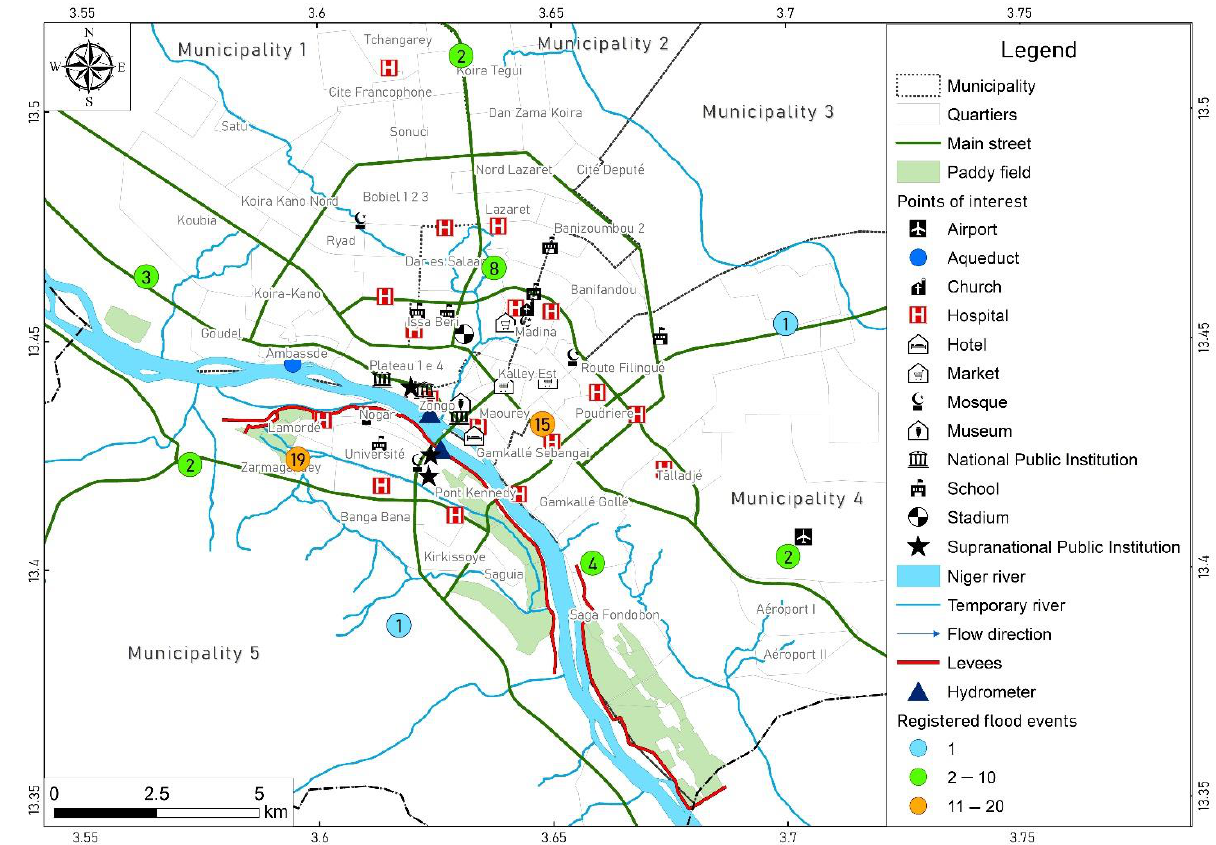
Figure 1. Map of the Niamey city with fluvial and pluvial flood events registered between 1998 and 2019 (Source BDINA- Base de Données sur les Inondations au Niger ANADIA [30]).